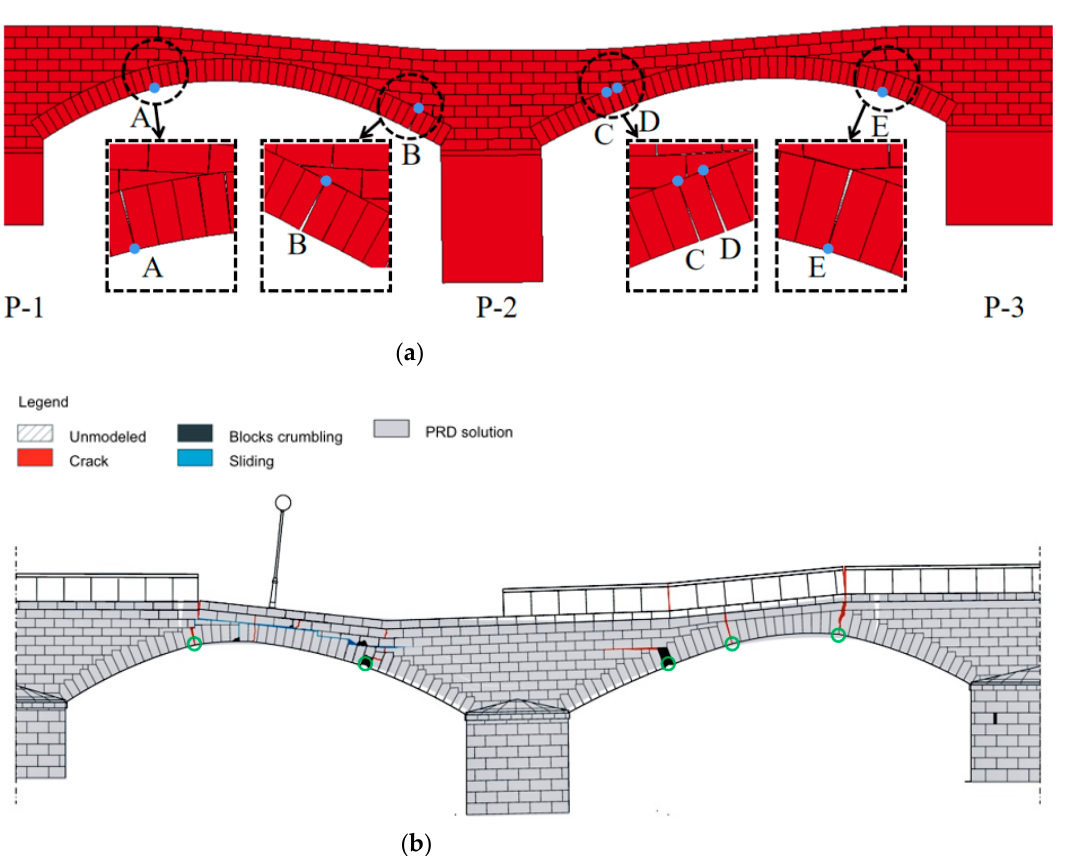
Figure 11. Comparison on arch hinges and cracks: ( a ) FDEM and ( b ) geometrical survey [17].